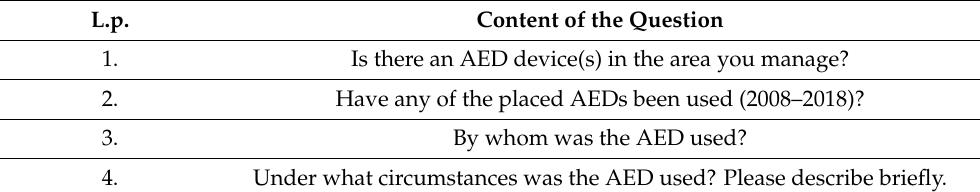
Table 1. Questions from a questionnaire targeting sites with an automated external defibrillator (AED) device.